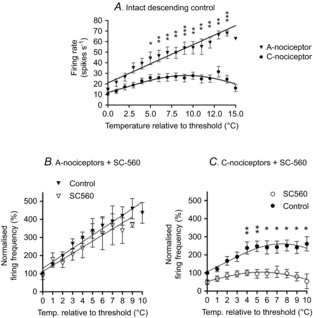
Temperature encoding of A-nociceptor information is maintained in the face of loss of prostanergic descending control from the PAG following SC-560 administration, whereas encoding of C-nociceptor information is lostA, temperature–response relationships to A-nociceptor (▾, n = 10; and ▽, n = 16) and C-nociceptor (○, n = 9; and •, n = 14) rates of skin heating, showing that the ability of cells to encode temperature is significantly different between fast and slow heat ramp-evoked responses under normal circumstances. Raw unit activity expressed as mean ± SEM is shown with linear and non-linear (Gaussian) regression lines modelling A-nociceptor- and C-nociceptor-evoked activity, respectively. B, normalised temperature–response relationships to A-nociceptor activation before and after SC-560 administration into the VL-PAG. C, normalised temperature–response relationships to C-nociceptor activation before and after SC-560 administration into the VL-PAG. The encoding functions denoted by the non-linear regression lines for C-nociceptors were significantly different after intra-VL-PAG injection (P < 0.0001, F test), whereas the A-nociceptor encoding function was unchanged (P = 0.32, F test). Data are expressed as mean ± SEM, with the regression lines for the data also shown. Note that in B the individual regression lines are shown although the comparison of the data shows that a single linear regression line fits both data sets, i.e. there is no difference between the data sets before and after SC-560. Individual points are also shown where significantly different between conditions. *P < 0.05, **P < 0.01, ***P < 0.001; two-way ANOVA followed by Bonferroni post hoc test. A-nociceptors: effect of drug F1,226 = 4.6, P = 0.03, effect of temperature relative to threshold F10,226 = 8, P < 0.0001, no interaction F10,226 = 0.4, P = 0.9. C-nociceptors: effect of drug F1,195 = 84.3, P < 0.0001, effect of temperature relative to threshold F10,195 = 2.3, P = 0.01, no interaction F10,195 = 1.2, P = 0.3.